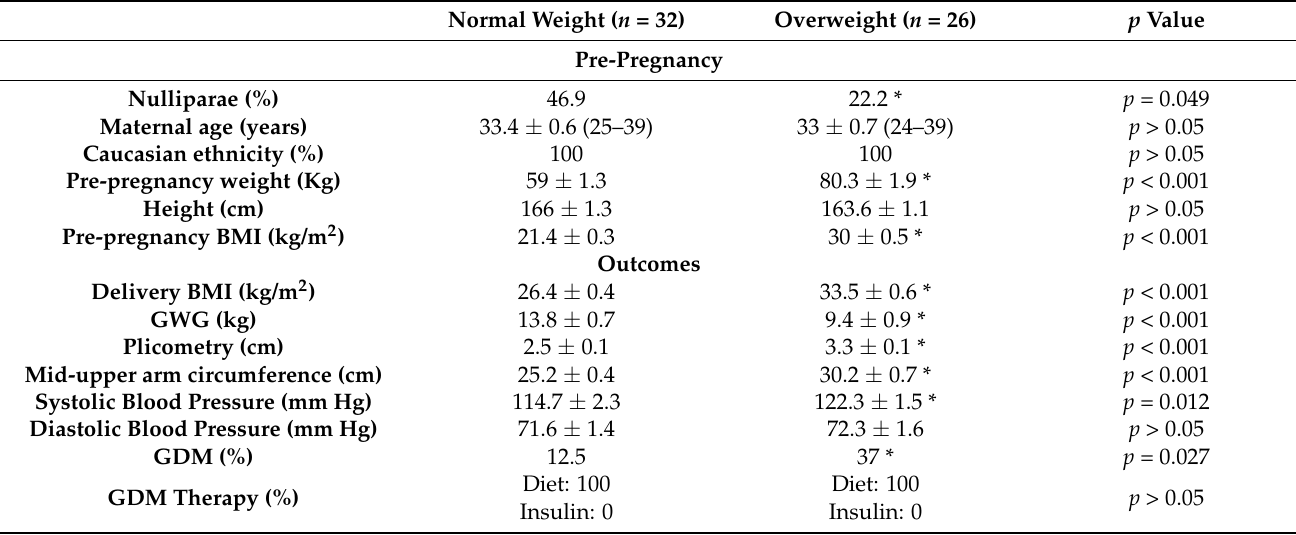
Table 1. Maternal pre-pregnancy characteristics and outcomes in normal weight and overweight pregnancies. Values are expressed as mean ± ES and percentage. Significant differences ( p < 0.05): * differences indicating a significant effect compared with normal weight. t -test and chi-square test were used.